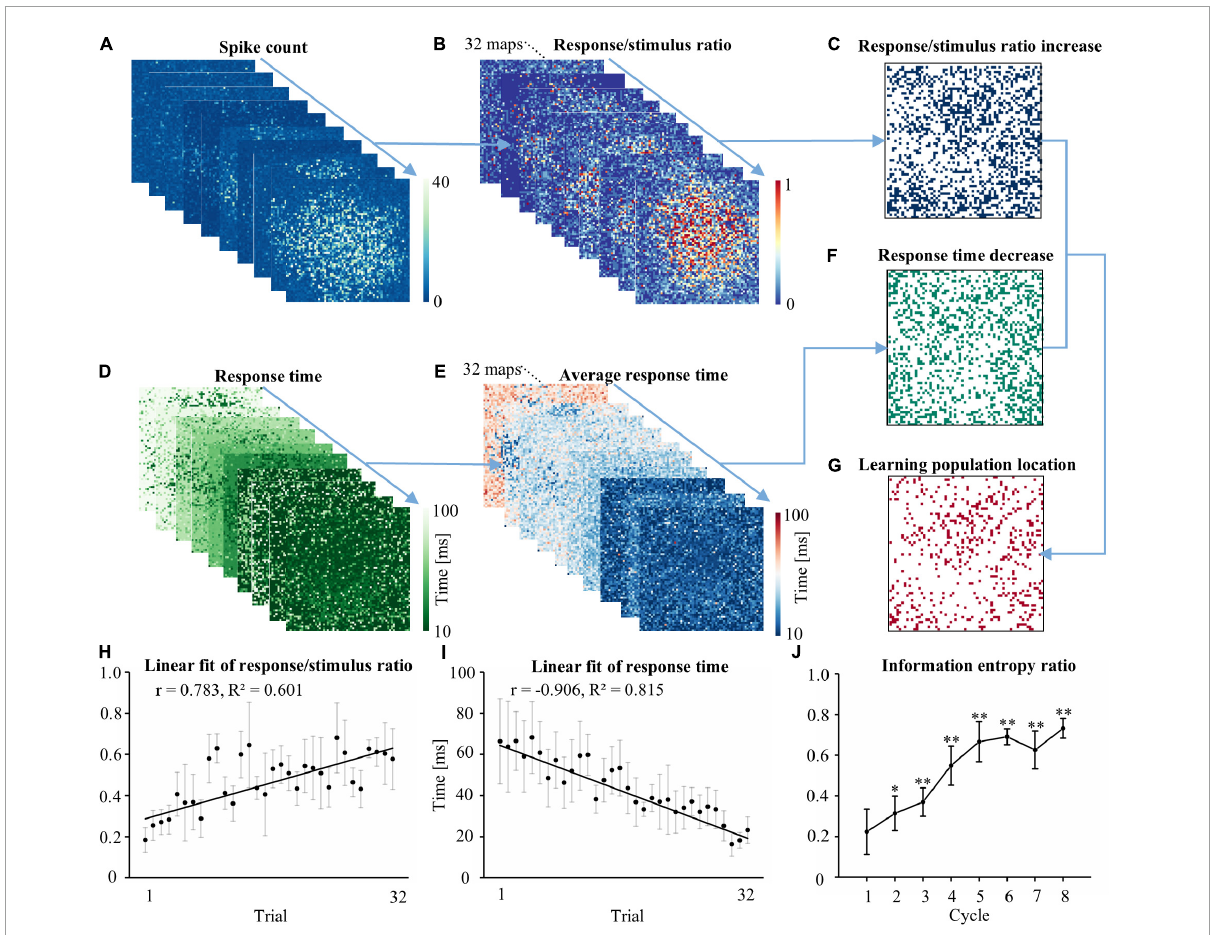
FIGURE2 Locating learning populations on the MEA. (A) The response map of each electrode in the network to the stimulus in a typical trial, which consisted of 10 stimuli. (B) The 10 representative response maps from each trial were used to produce an R/S ratio map. The experiment consisted of 32 R/S ratio maps. (C) First-order linear modeling was performed on each electrode in the 32 R/S ratio maps to identify the spatial position where the slope of the fitted line was greater than 0. (D) The RT map of each electrode in the network to the stimulus in a typical trial. (E) The 10 representative RT maps from each trial were used to produce an average RT map. (F) First-order linear modeling was performed on each electrode in the 32 average RT maps. The spatial position where the slope of the fitted line was less than 0 was identified. (G) The spatial location of overlap between C and F was determined as the spatial position of the learning population in the cultured neuron network. The location of the overlap reflected the exact electrode position. (H) Linear regression of trial vs. the R/S ratio of the learning populations. (I) Linear regression of trial vs. RT for the learning populations. (J) The ratio of the information entropy of the learning population accounted for the total information entropy in the cultured neuronal network in each cycle ( n = 5 cultures. Data collected during 10–200 ms after the stimulus were analyzed. * p < 0.05 vs. Cycle 1, ** p < 0.01 vs. Cycle 1. R/S: response/stimulus, RT: response time).